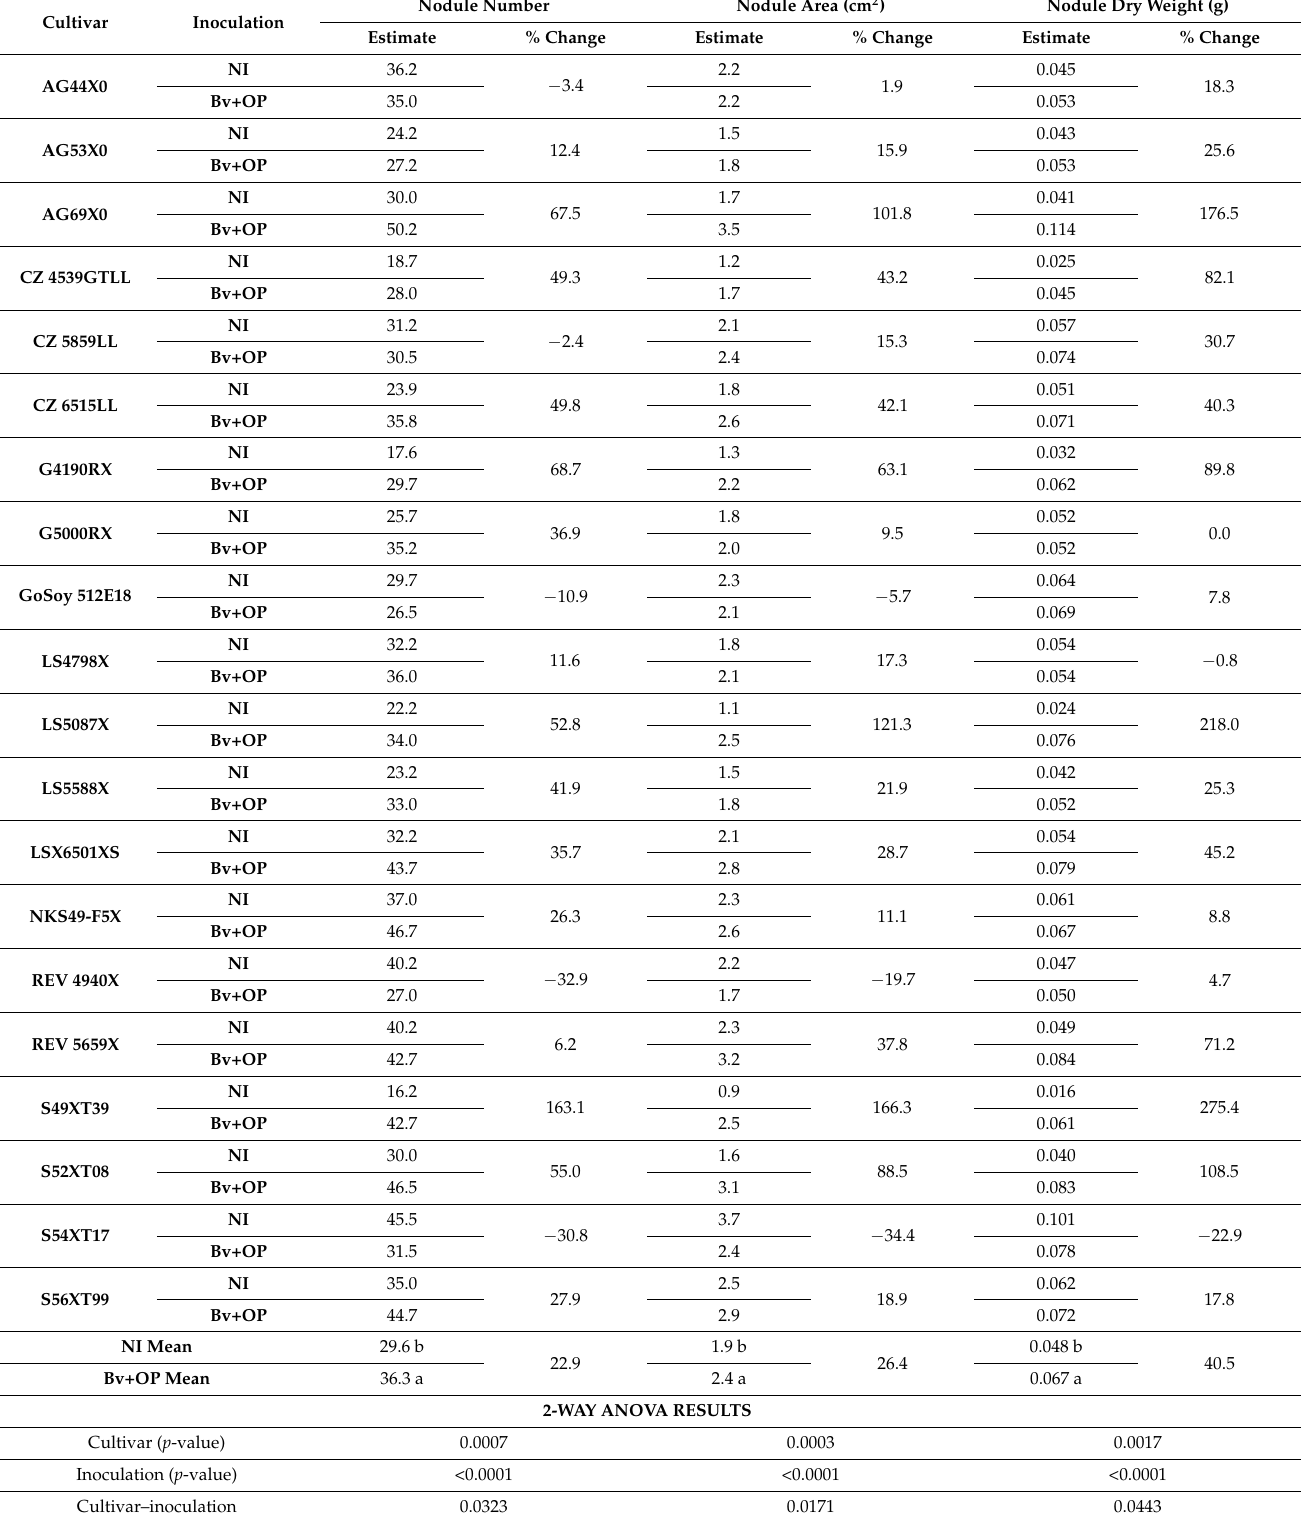
Table 2. Response of inoculation with Bv AP193 plus OP on nodule number, nodule area and nodule dry weight in a preliminary greenhouse experiment with 20 soybean cultivars. The bottom section of the table shows the ANOVA results ( p -value) for the effect of cultivar, inoculation and the interaction cultivar–inoculation. Different letters indicate significant differences within the treatment